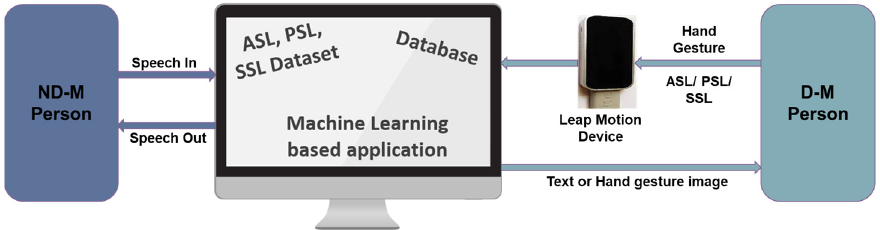
Figure 4. Block diagram of the communication system.